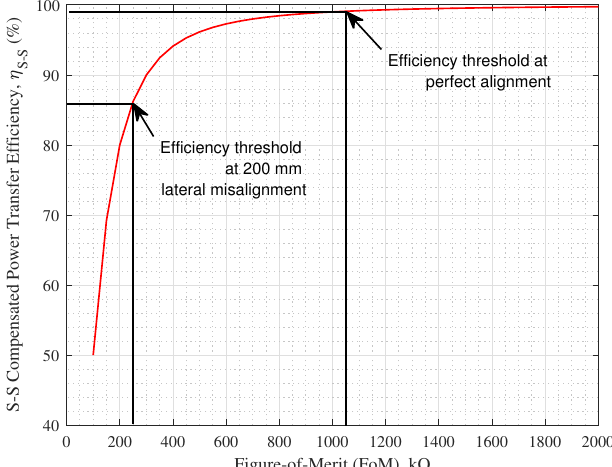
Figure 5. Theoretical relationship between the S-S compensated power transfer efficiency and FoM, showing desired efficiency